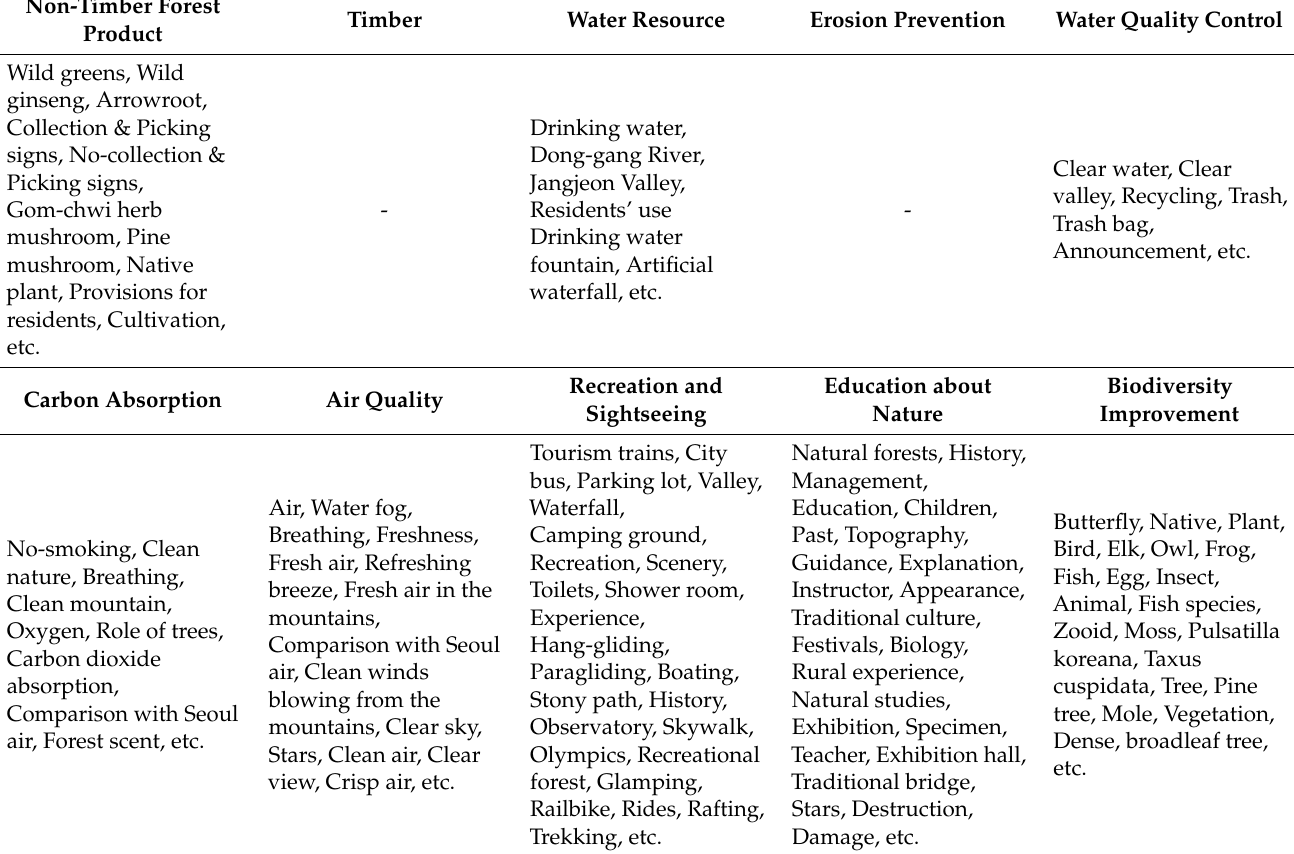
Table 2. Categorization of texts obtained from word